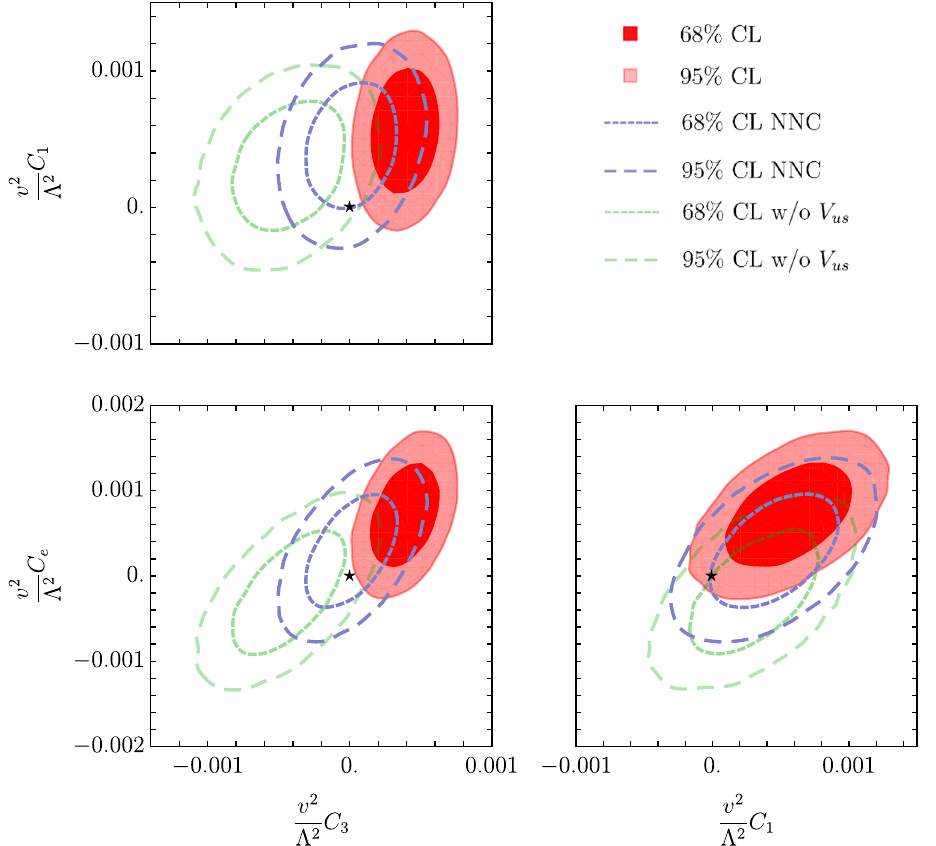
, C (1) , C φe . The green dashed lines correspond φ‘ φ‘